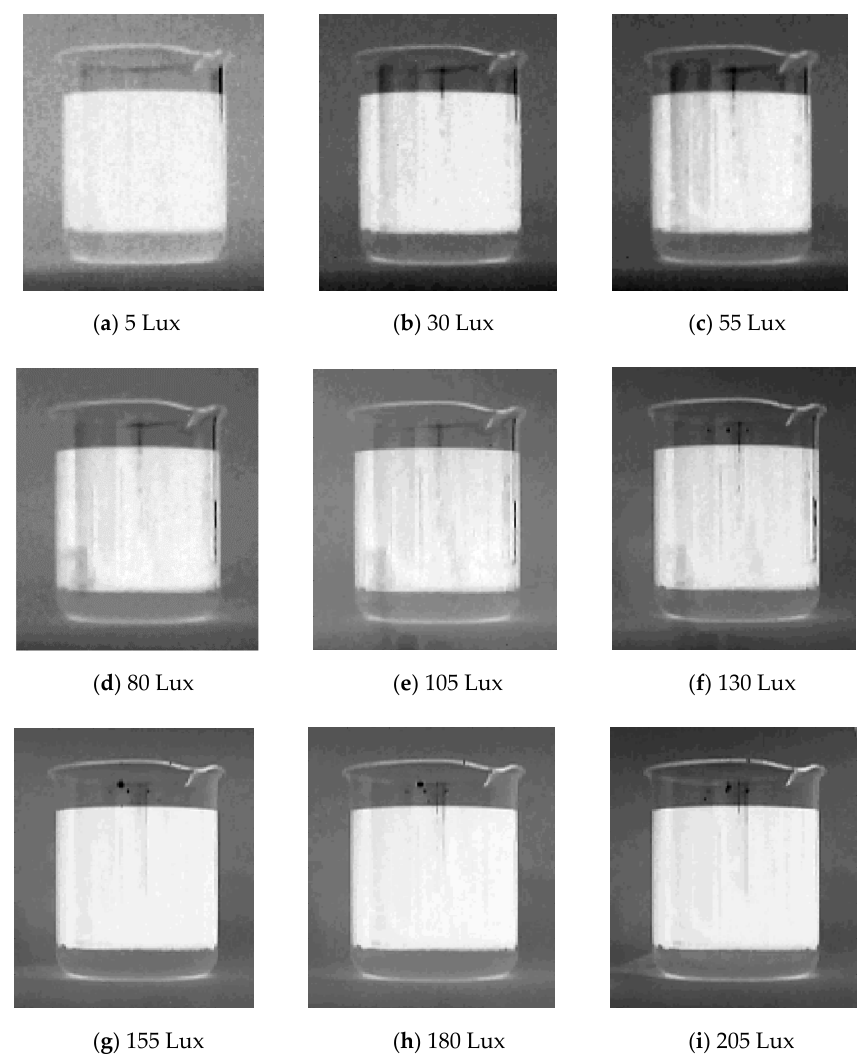
Figure 8. Grayscale images of the water–oil layered mixture of different illumination intensities.